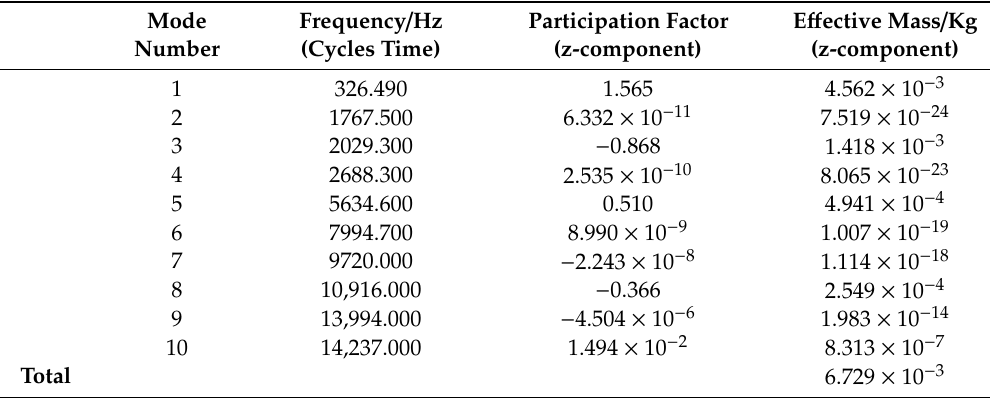
Table 2. Frequency, participation factor and e ff ective mass for 10 eigenvalues.